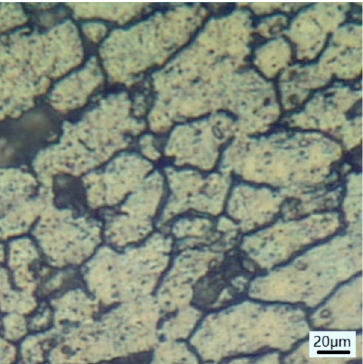
Figure 4. Microscopic morphology of corrosion experienced by test specimen of aluminum alloy 2219 containing an FSW joint.